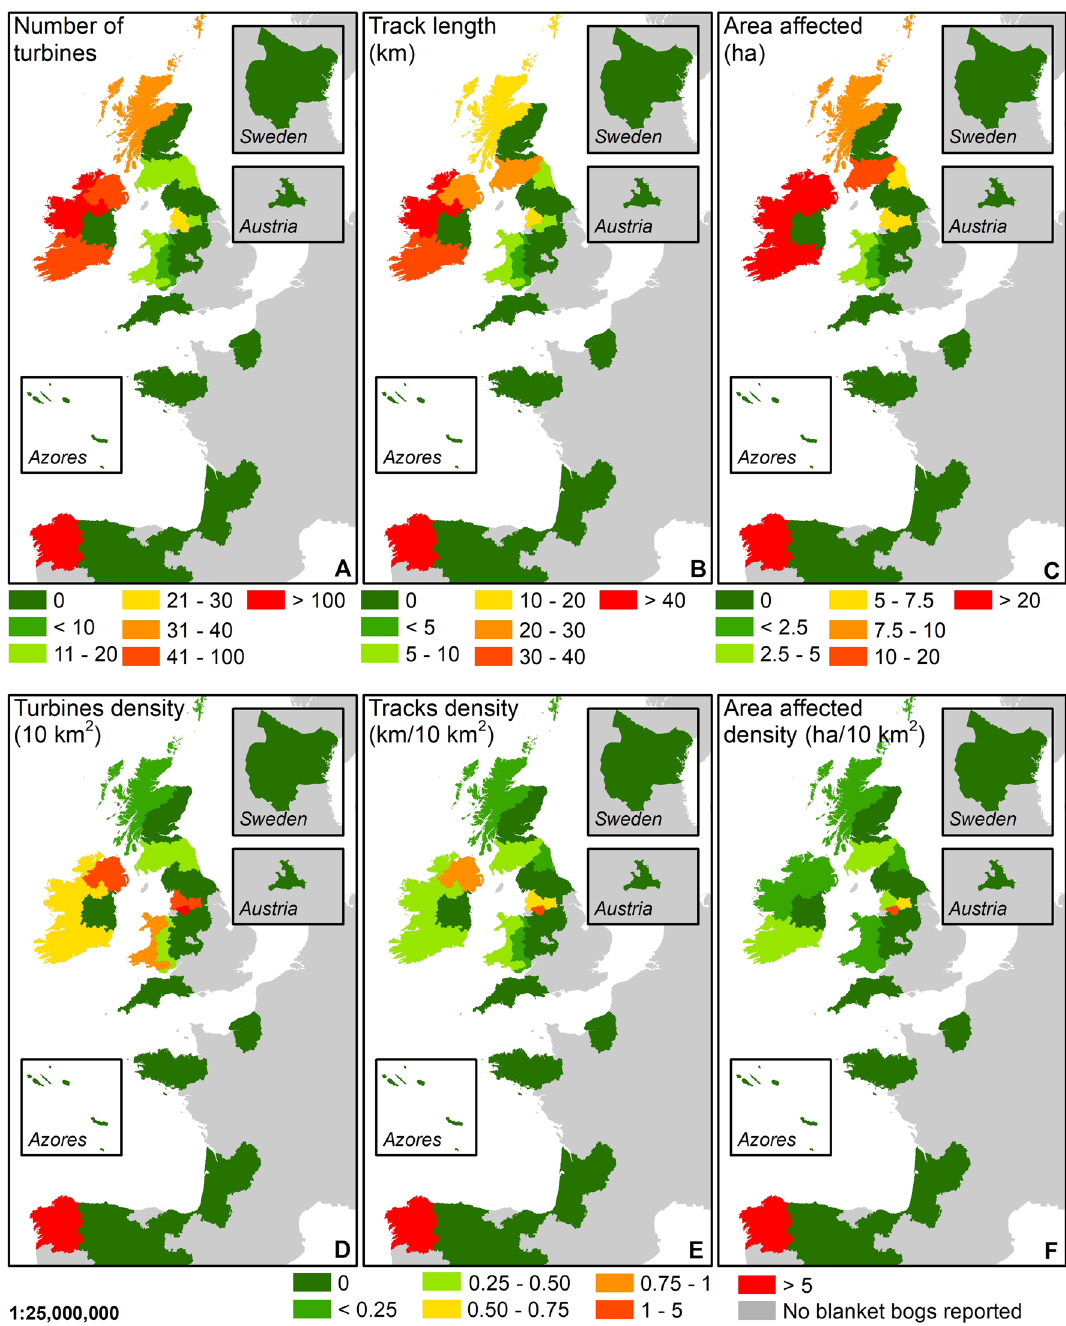
Figure 2. The extent of windfarm developments across the EU and UK on blanket bog habitat 7130 based on the 2013–2018 conservation status report 19 prior to Brexit by European regions NUTS level 2 32 . Note: Boundaries of the regions have not been added to improve legibility. The political geographical regions do not represent the extent of blanket bogs. ( A ) Total turbines on blanket bog habitat 7130. ( B ) Tracks length on blanket bog habitat 7130. ( C ) Total area affected by windfarm developments on blanket bog habitat 7130. ( D ) Density of turbines per 10 km 2 of blanket bog habitat 7130 by European regions. ( E ) Density of tracks per 10 km 2 of blanket bog habitat 7130 by European regions. ( F ) Density of area affected by windfarm developments per 10 km 2 of blanket bog habitat 7130 by European regions. Datasets for blanket bog habitat 7130 : Austria, Portugal, Sweden and France 19 , Scotland 33 ; England 34 ; Wales 35 ; Republic of Ireland 36 and Spain 37 . Dataset for peatlands (only priority habitat) : Northern Ireland 38 . The location of mapped regions in the Azores, Austria, Sweden, and the full extent in Spain is shown in Fig. A (Supplementary materials). Map created in ArcGIS